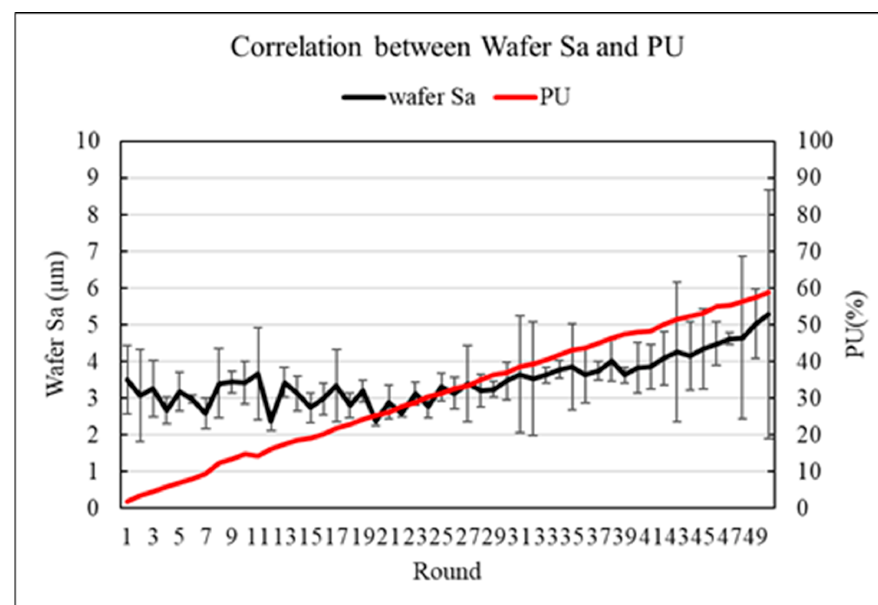
Figure 16. The correlations between wafer Sa and PU.